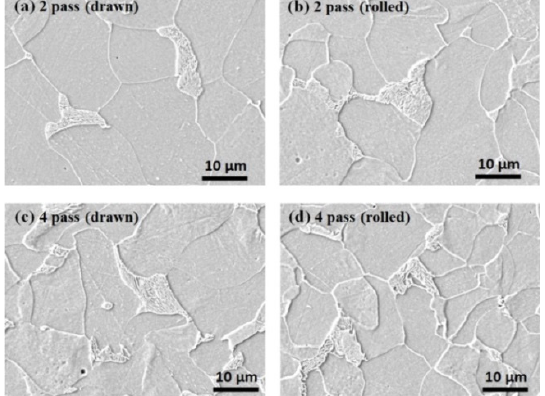
Figure 6. Comparison of the microstructures of the drawn and caliber-rolled ferritic steel wires with strain. Quarter region was measured.